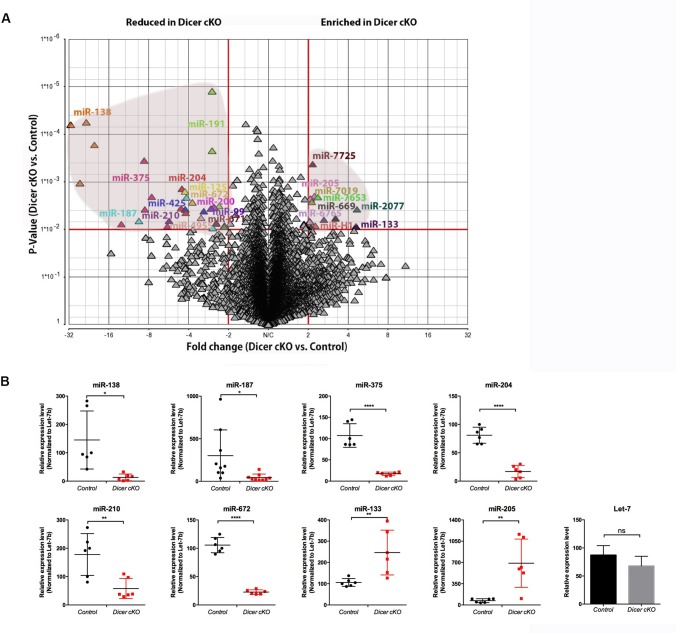
miRNA signature change in the proximal epididymis region (i.e. initial segment/caput) of Dicer1 cKO mice.(A) The different miRNA profiles of Dicer1 cKO and control mice are plotted on the volcano plot according to two-way ANOVA parameters, i.e. p-value and fold-change. Only miRNAs with a fold change above 2 and a p-value below 0.01 (red lines) are annotated. (B) Changes in mature miRNA production in Dicer1 cKO were assessed by qRT-PCR. Data represent experimental duplicates on n = 3 biological samples per group and are normalized to Let-7b expression. ns: non significant, *p < 0.05, **p < 0.01, ***p < 0.001, ****p < 0.0001.